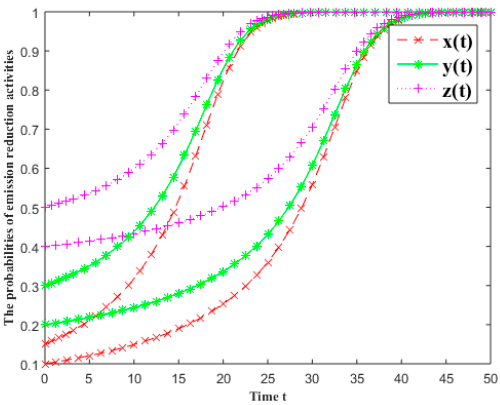
Figure 2. The effects of the initial states on the probabilities of emission reduction activities.